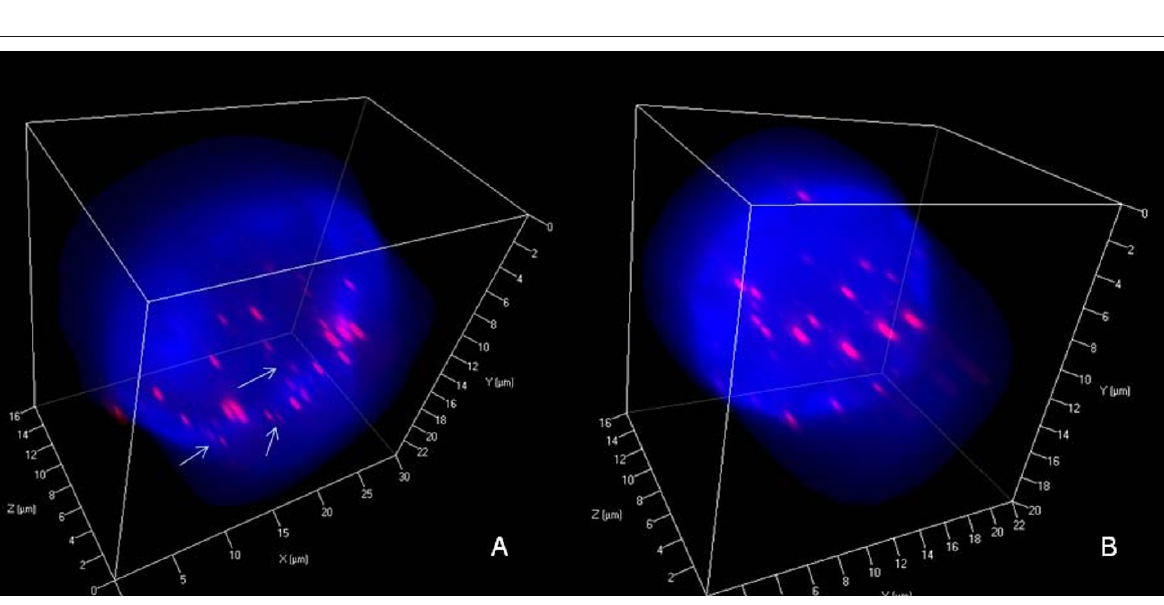
Figure 4 3D nuclear staining of telomeres and total DNA of H-cells . A. Mononuclear U-HO1 H-cell (blue) shows few very short (arrows) but mainly short and mid-sized telomeres (red) analogous to those identified in mononuclear U-HO1-PTPN1 H-cells